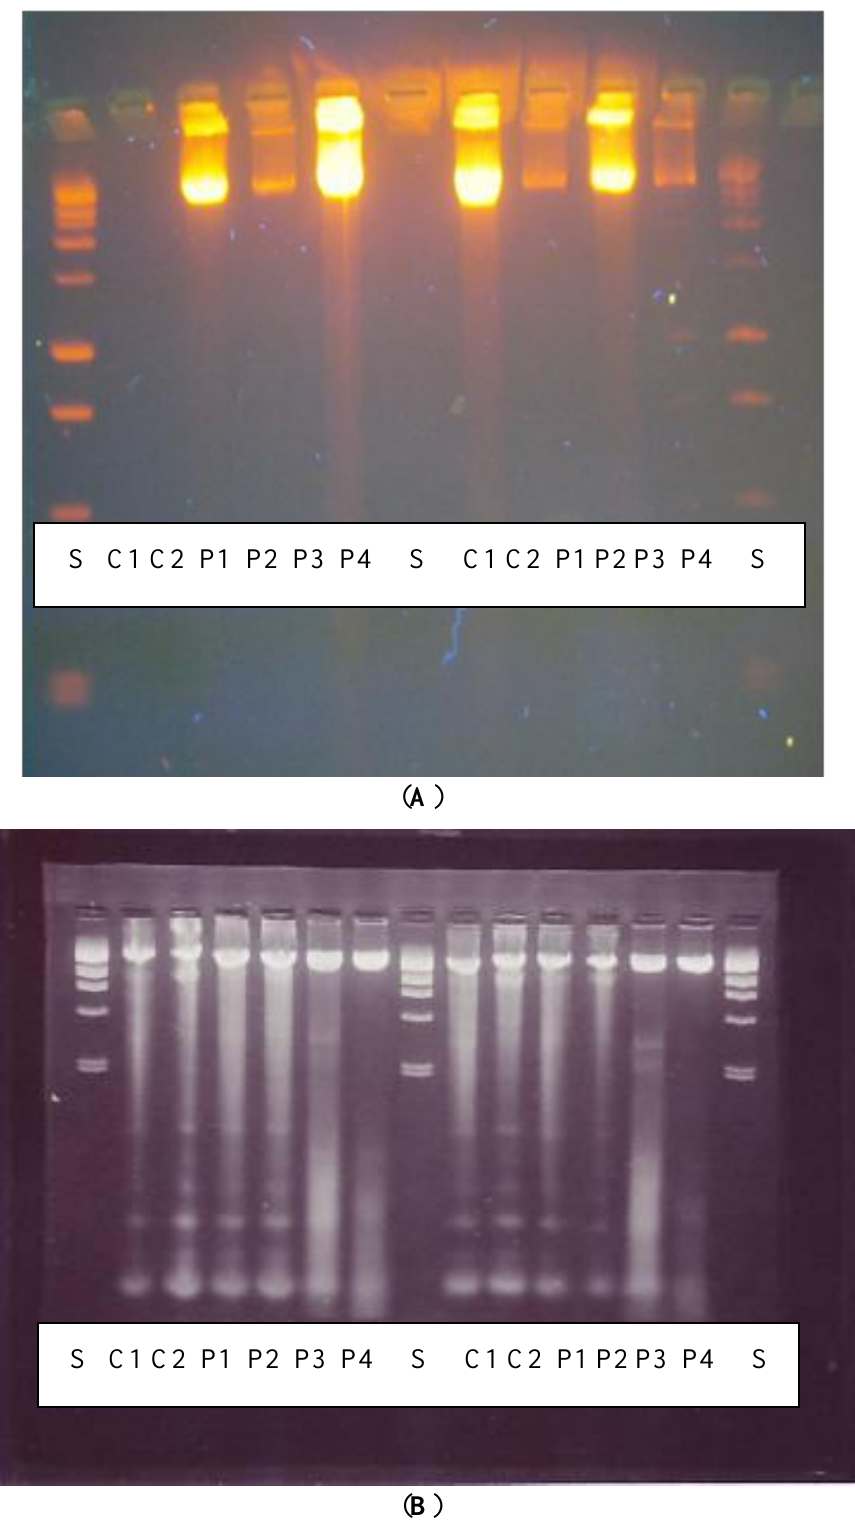
Figure 3. Effects of PHMB on DNA fragmentation using 1% agarose gel electrophoresis in ( A ) HepG2 cells; ( B ) Neuro-2A